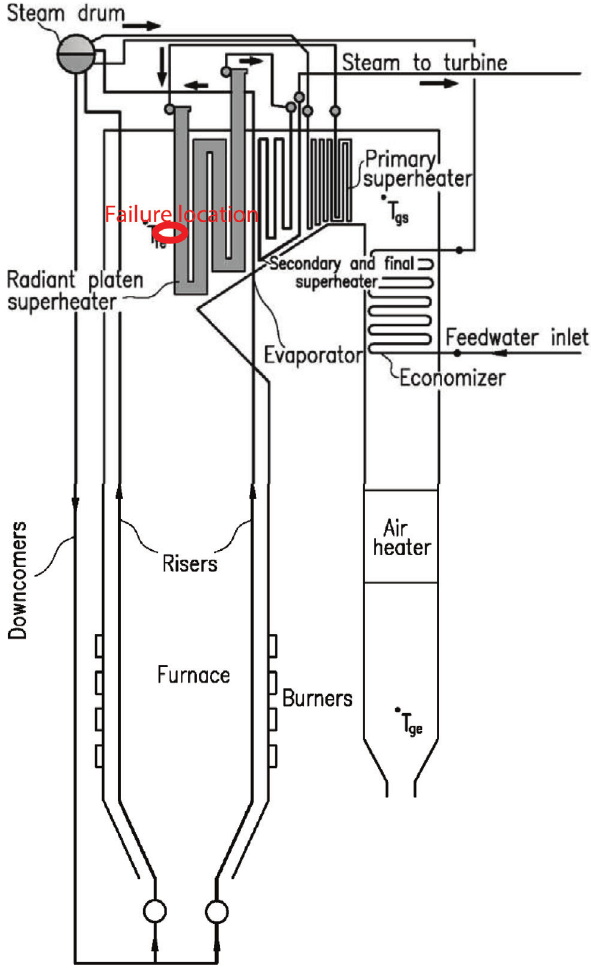
Table 1: Chemical composition of the failed